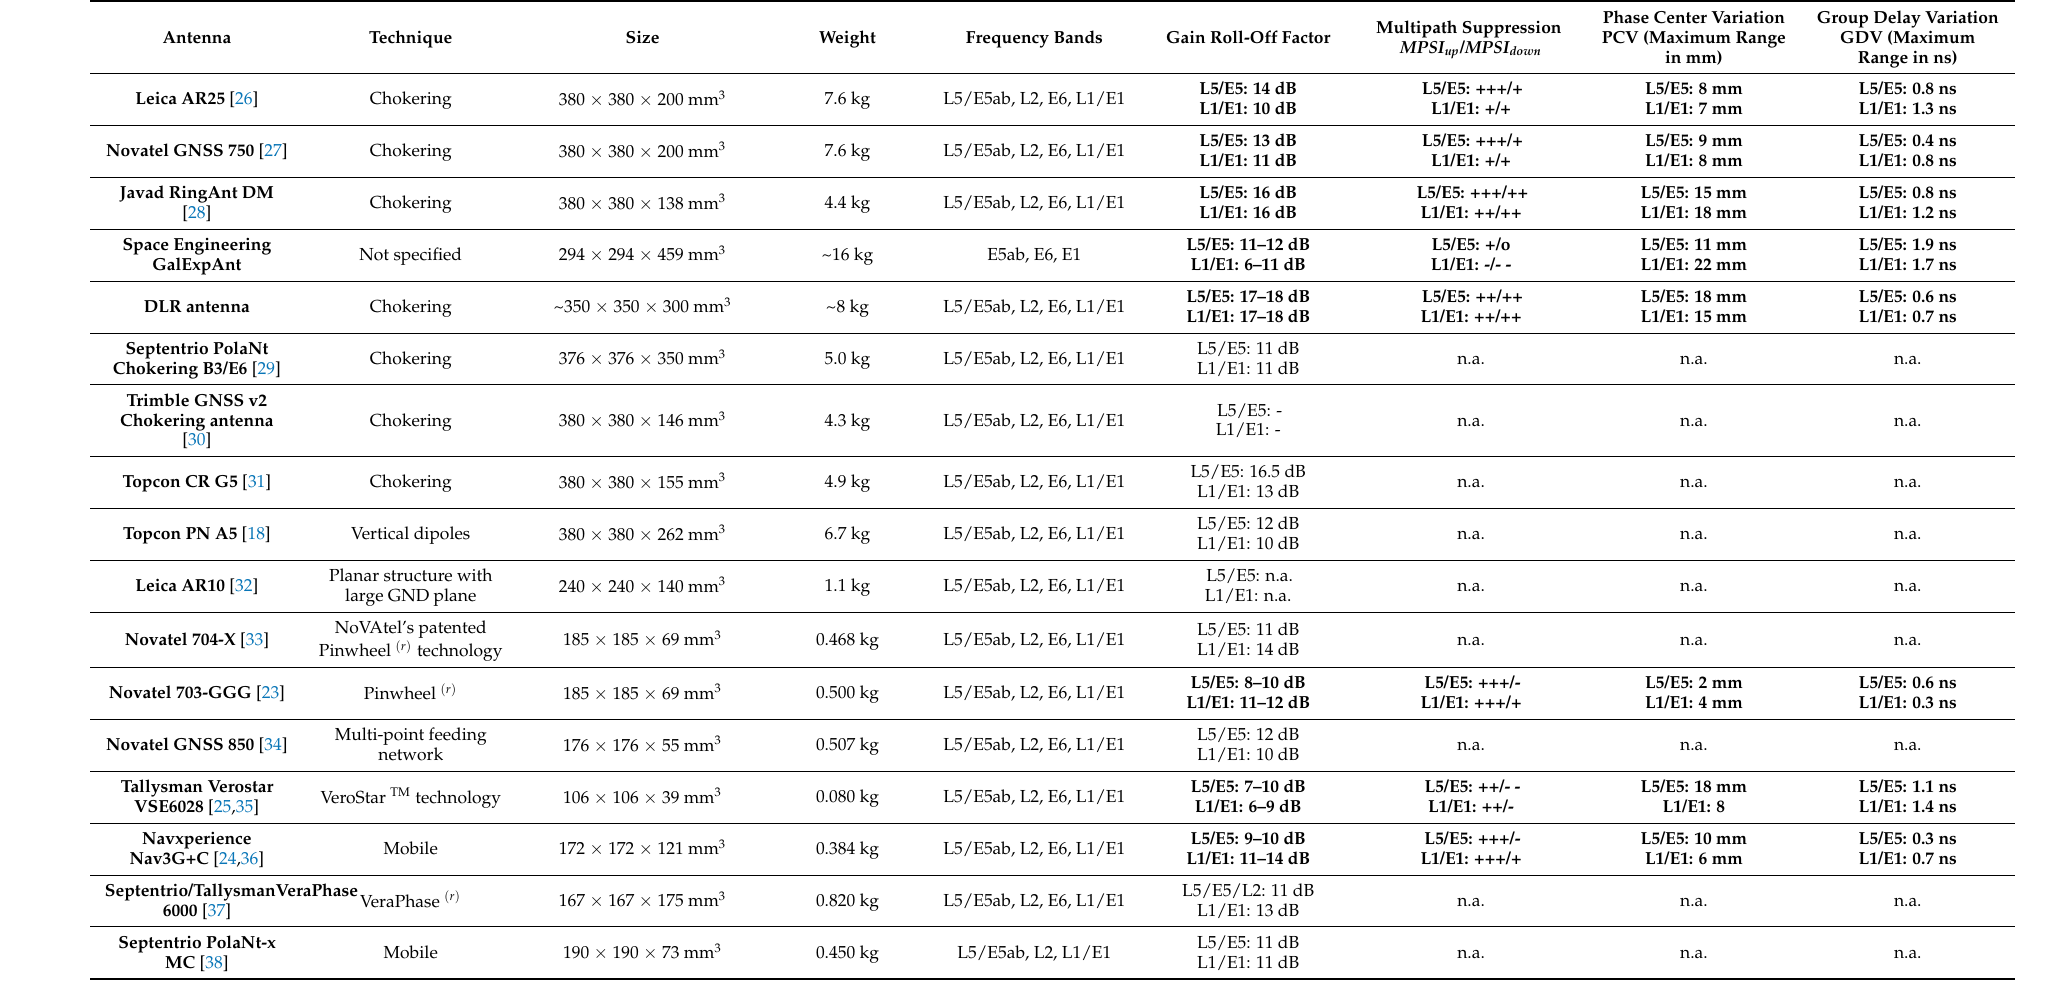
Table 1. Comparison of GNSS Rx antennas for ground